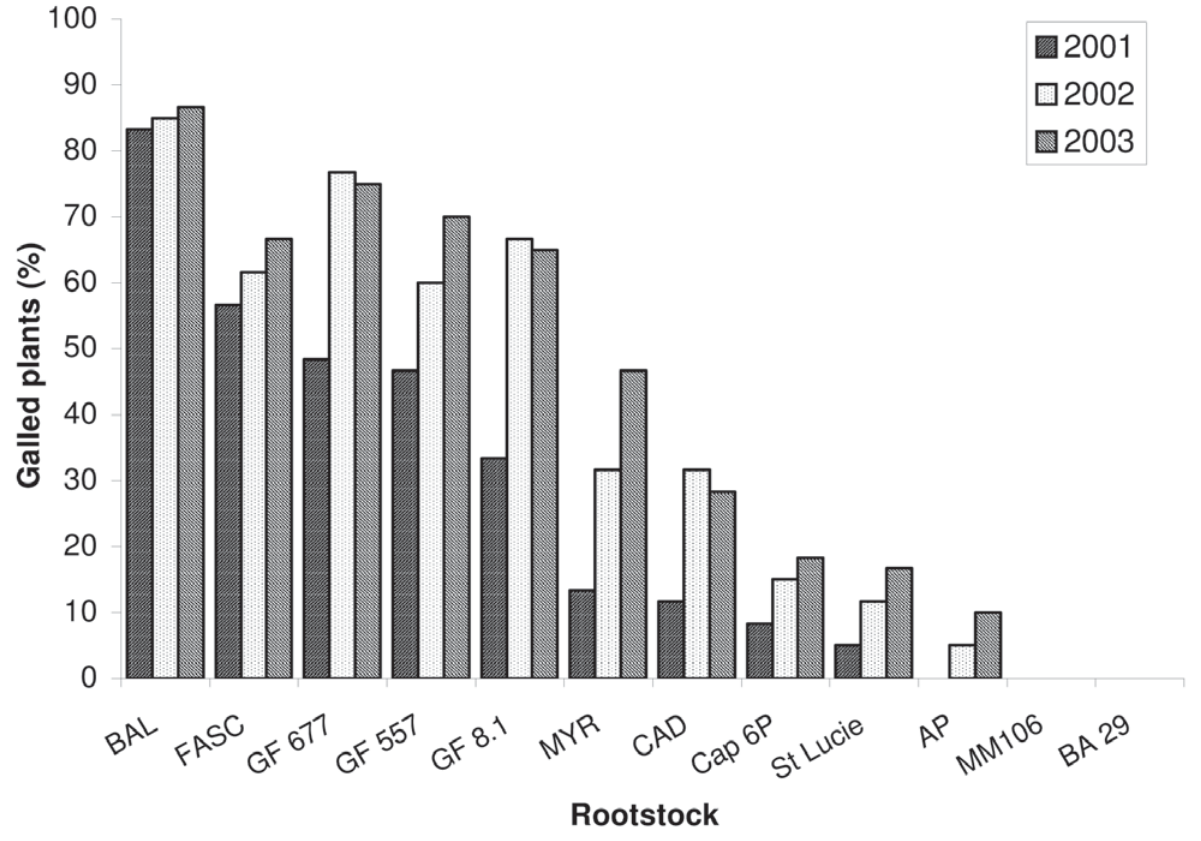
Fig. 5. Percentage of galled plants after growing in a naturally contaminated soil in 2001, 2002 and 2003. Legend: BAL, bitter almond; Fasc, Fasciuneddu; MYR, myrobolan; CAD, Cadaman; AP,